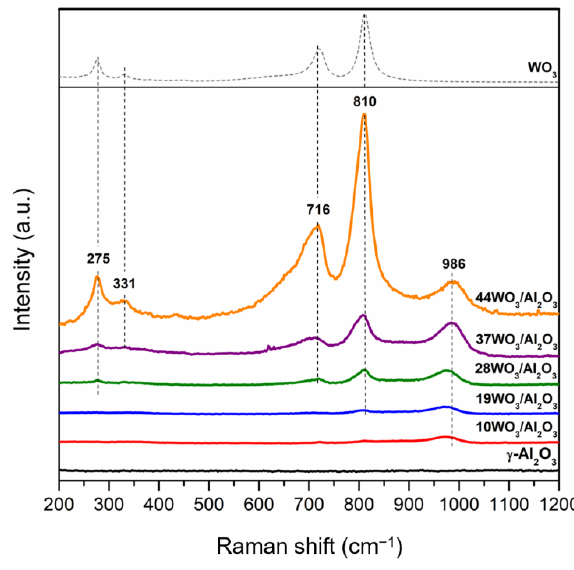
γ -Al 2 O 3 catalysts.